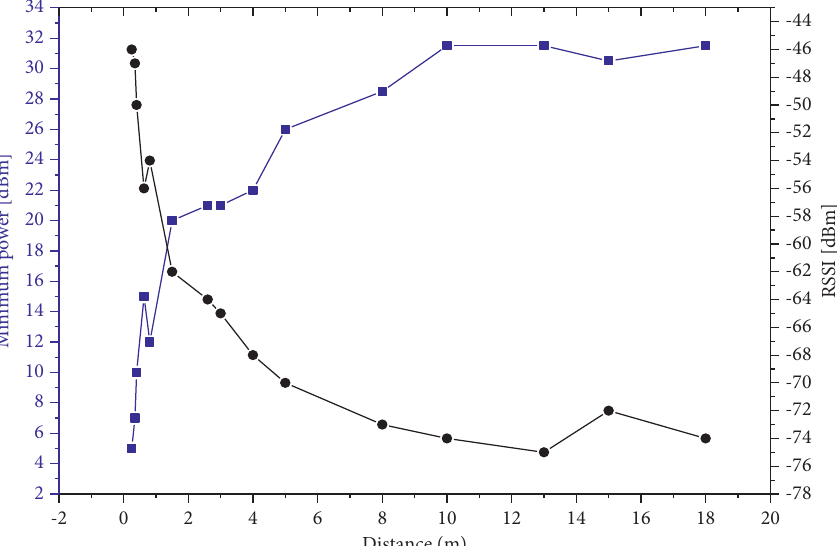
Figure 12: Read range and RSSI which are measured when the tag antenna is placed on the metal plate (30cm × 30cm) in the direction of φ � 0 ° in the xy